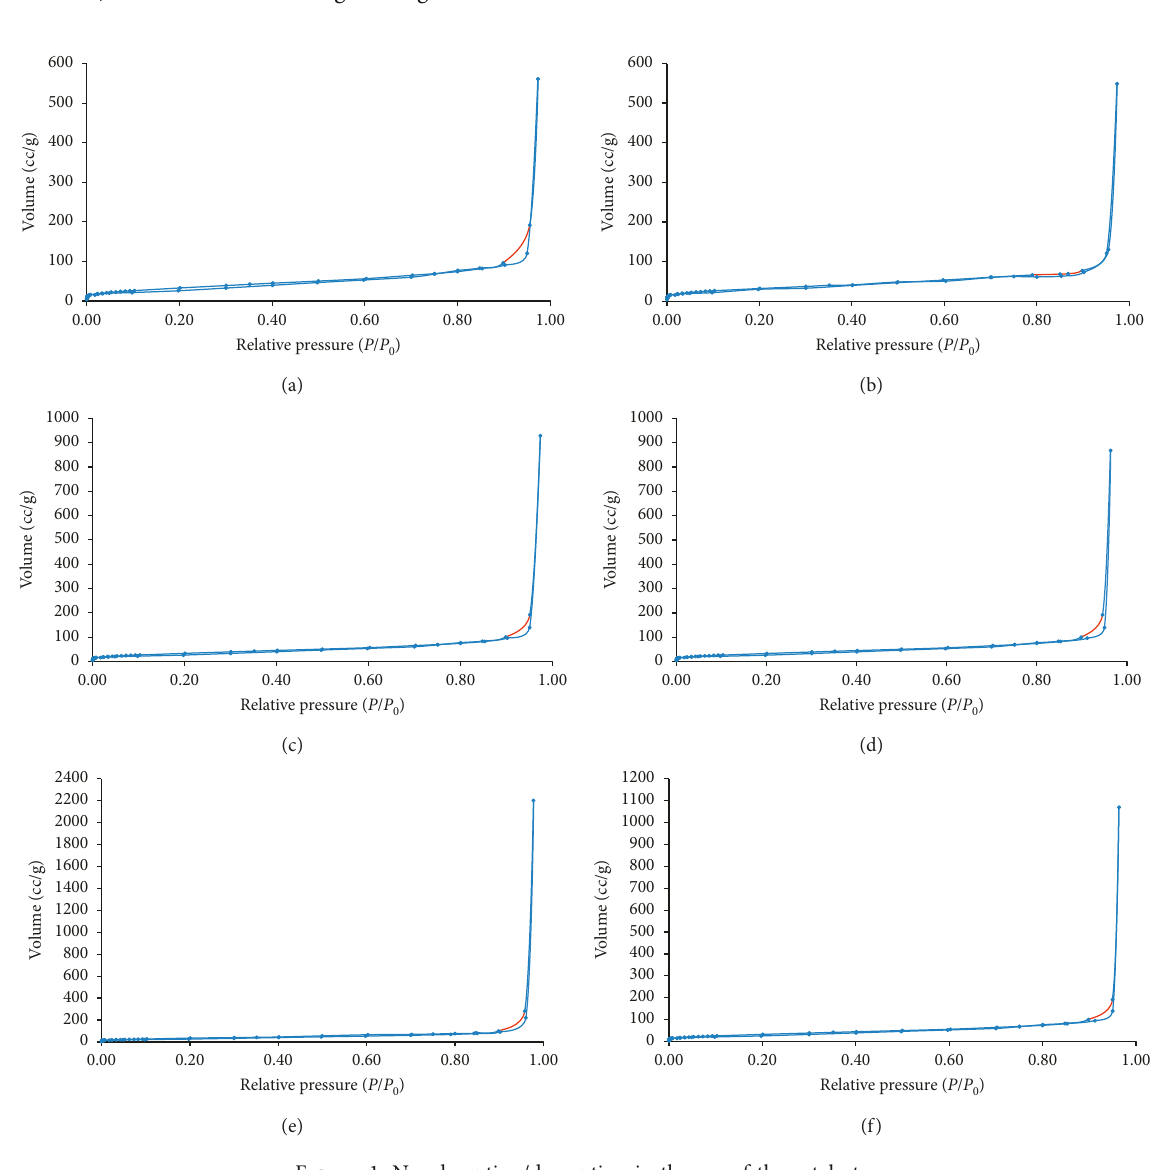
Figure 1: N 2 adsorption/desorption isotherms of the